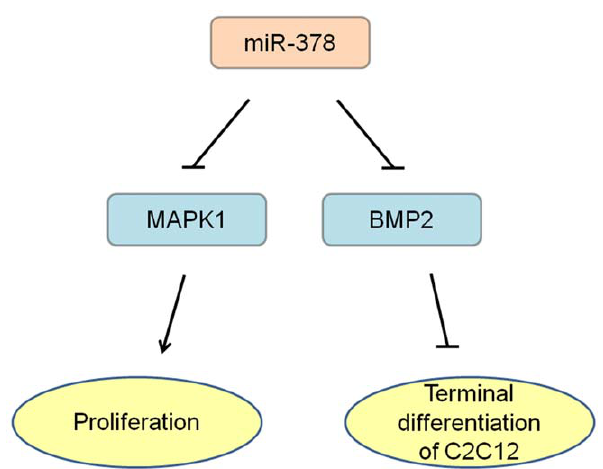
Figure 5. Presumed regulatory network of miR-378 in myogen-